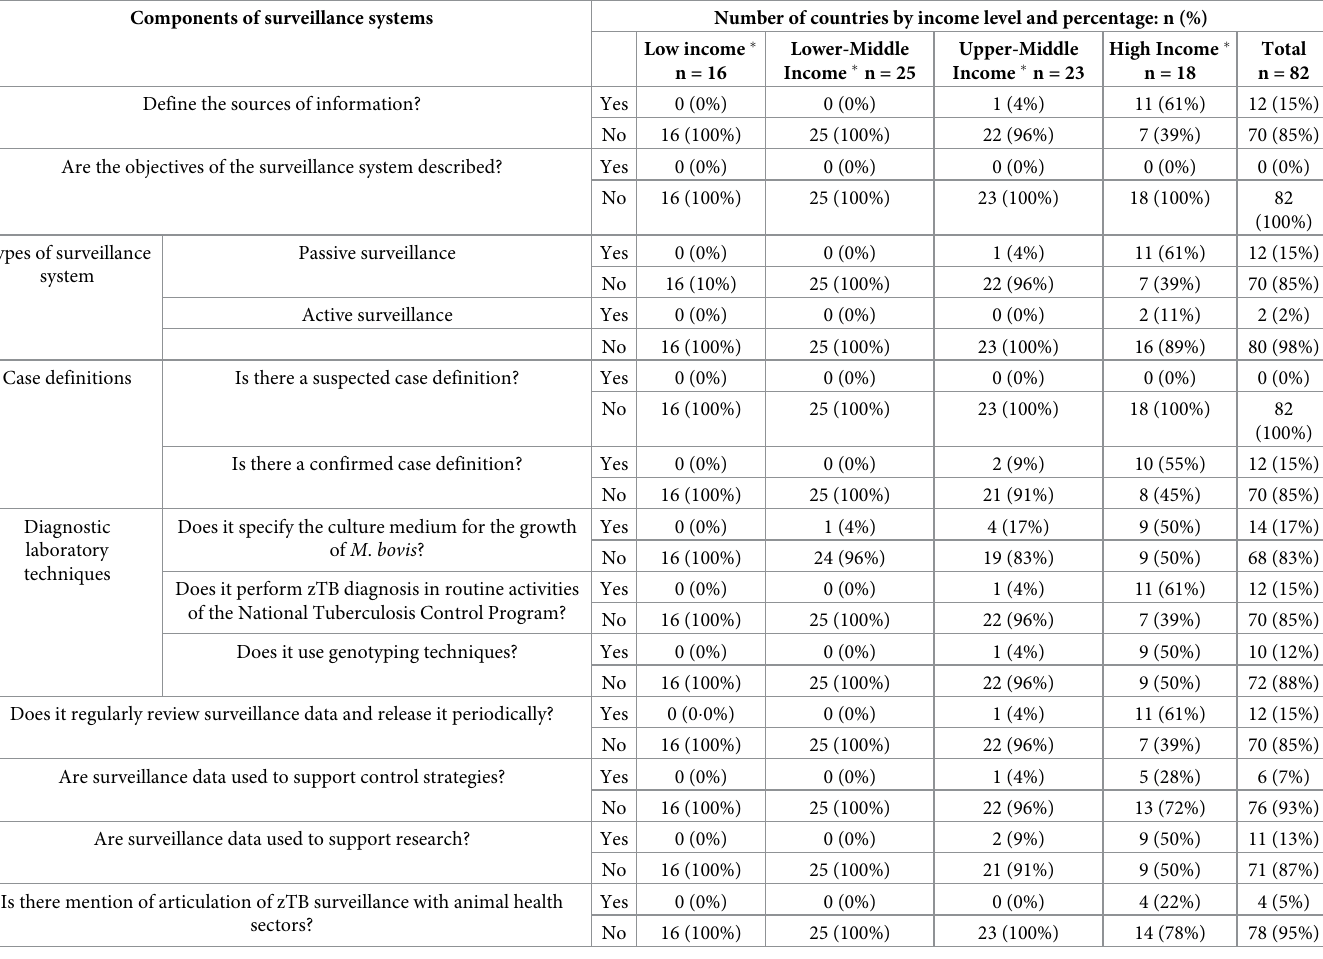
Table 1. Basic components of surveillance of human tuberculosis caused by Mycobacterium bovis in 82 countries assessed, by income level. Components of surveillance